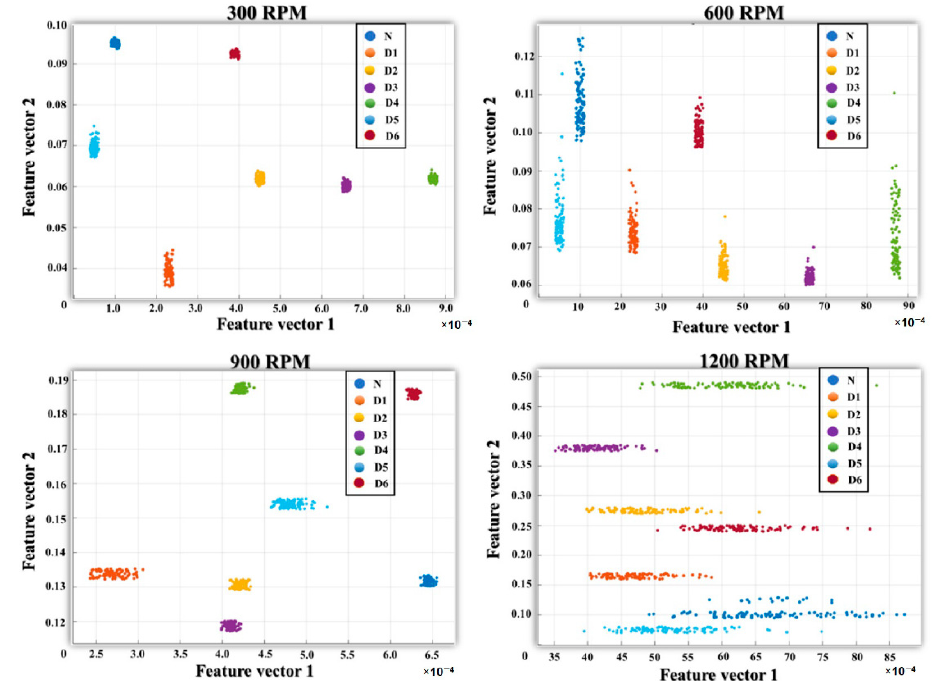
Figure 14. The feature space distributions of seven defect types using the features extracted by sparse autoencoders under four various rotational speeds.